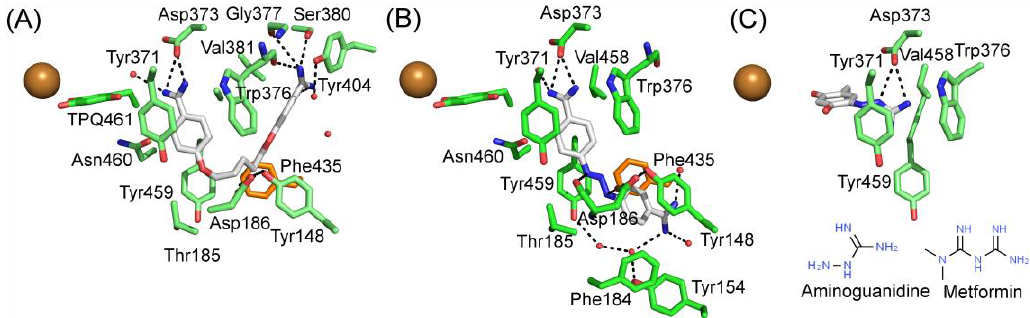
Figure 6. hDAO interactions with off-targets. ( A ) Pentamidine; ( B ) Berenil; ( C ) Aminoguanidine. Phe435 of Arm I from the other monomer is shown in orange.